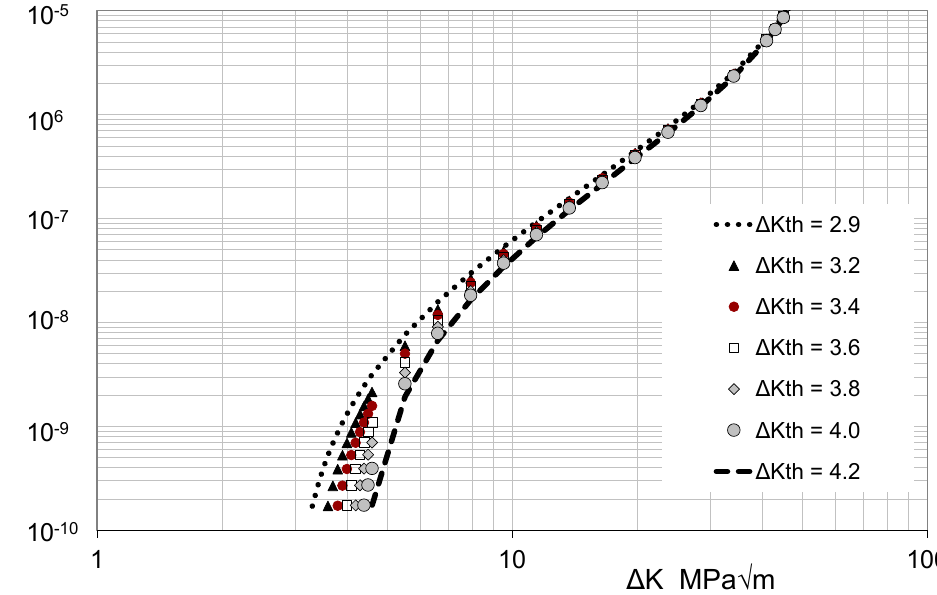
Figure 1. The scatter seen in the family of da / dN versus ∆ K curves corresponding to the Virkler, Hillberry and Goel crack growth data.